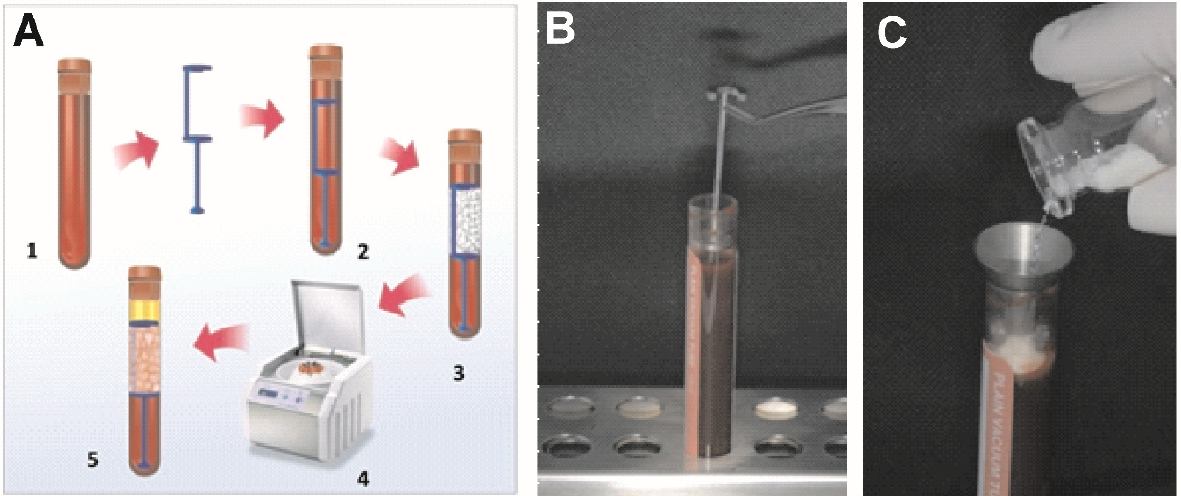
Figure 2. ( A ) The sequence of steps of sticky bone preparation with the SBPD. The process starts with the peripheral blood collection (Step 1), followed by the placement of the device (Step 2), the addition of particulate biomaterial (Step 3), and centrifugation according to the platelet aggregate protocol chosen (Step 4). It ends with the removal of the SBPD ® with the complete sticky bone preparation (Step 5). ( B ) Detailed view of the insertion of the SBPD into the tube. ( C ) Detailed view of the sterile metallic funnel and the particulate bone substitute being inserted.